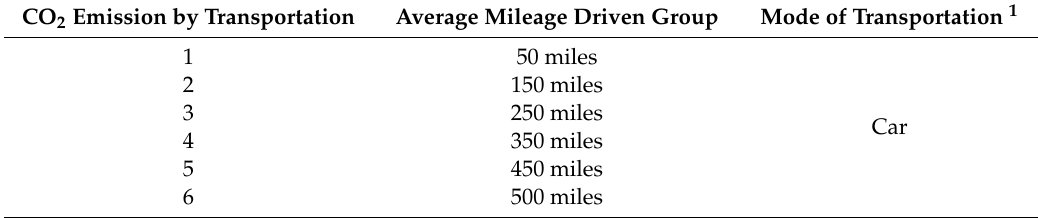
Table 2. Groups of CO 2 Emissions Generated per Mileage Driven Group for Car Mode.